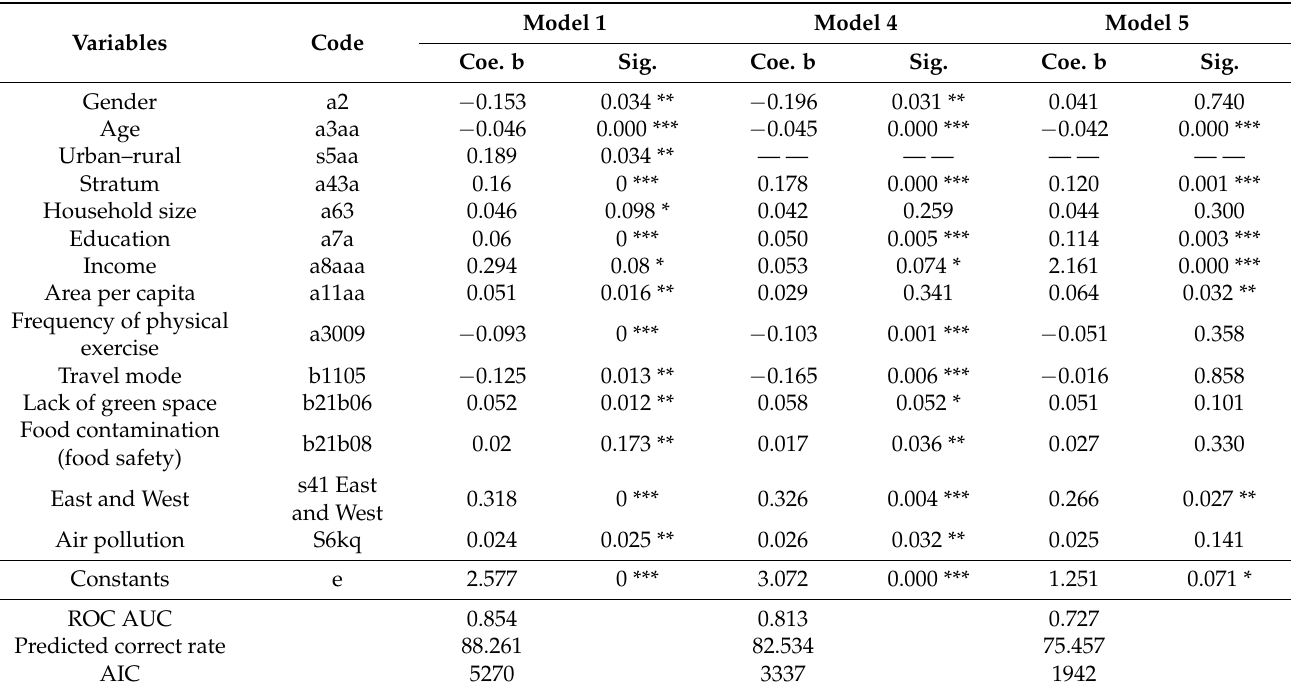
Table 4. A comparison of the regression results for urban–rural differences in the whole